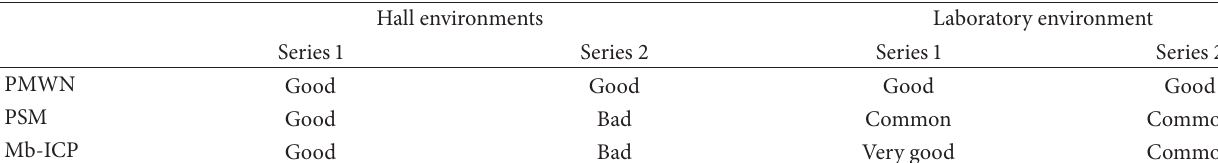
Table 5: Performances of the approaches in the different series.